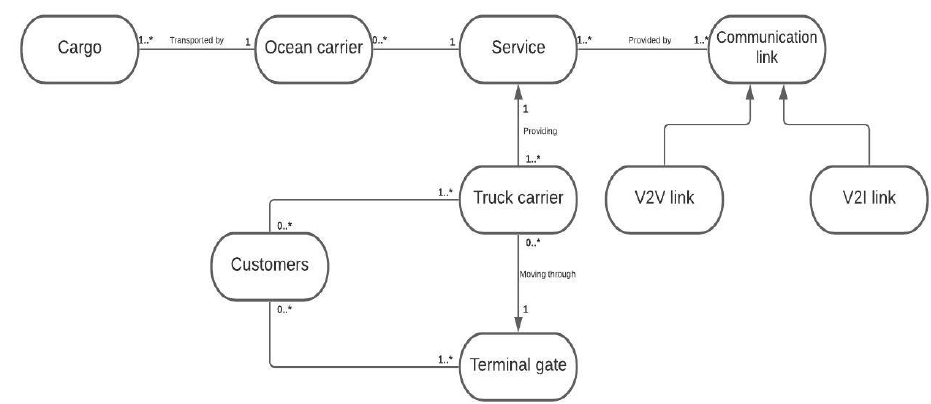
Figure 5. UML activity diagram for the system of cargo transportation (* denotes many). Table 1. Conceptual prototype of the proposed system for cargo